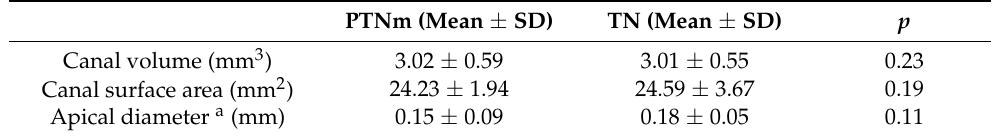
Table 1. Sample baseline characteristics of the 60 mesial canals were included in the study. a Apical diameters 1 mm from apical foramen. PTNm, modified ProTaper Next technique; TN, TruNatomy technique.